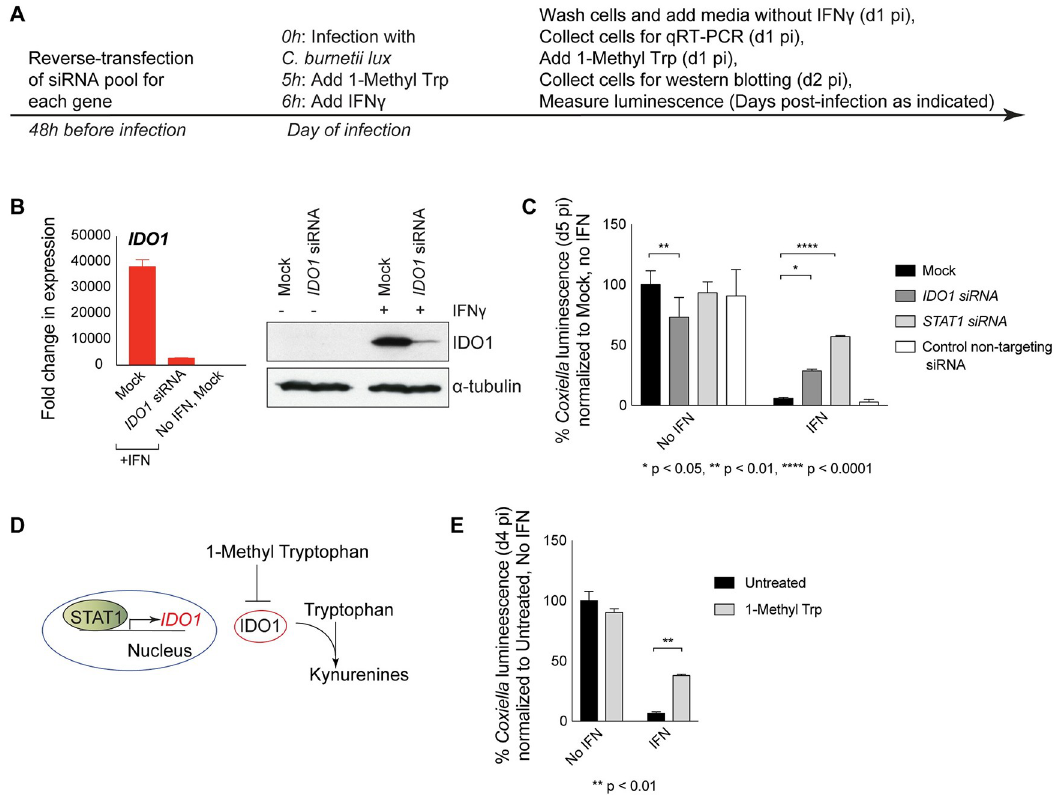
Fig 3. Indoleamine 2,3-dioxygenase 1 (IDO1) enzymatic activity is important for restricting C . burnetii replication. Experimental setup is laid out in A. Induction of IDO1 expression by IFN γ and knockdown efficiency of siRNA were determined by qRT-PCR and western blotting (B). Knocking-down IDO1 by siRNA (C) or blocking the enzymatic activity of IDO1 by 1-Methyl tryptophan (E) allows replication of C . burnetii lux in IFN γ -treated cells but does not increase C . burnetii luminescence in untreated cells. Mechanism of action of IDO1 is depicted in